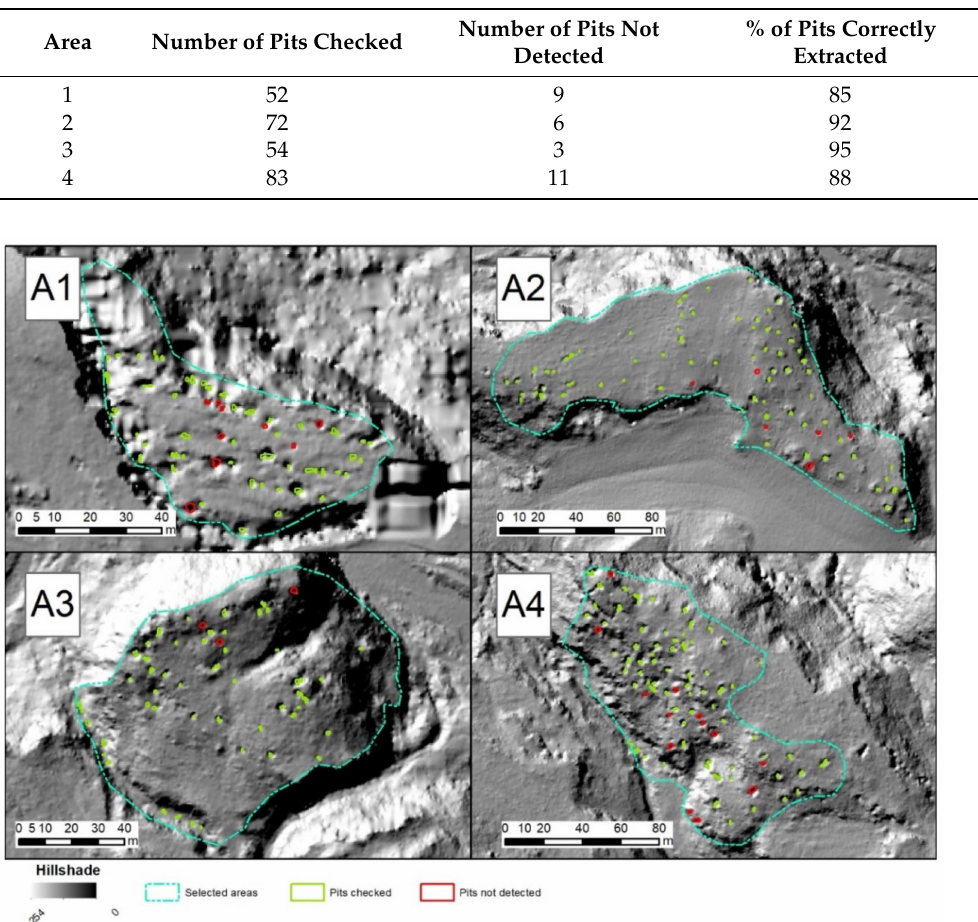
Figure 9. Validation conducted exploiting the enhancement of VTS (on the left), the topographic profile from the DEM (on the right) and ground check. The VT herein showed is HS. Example of profiles derivates for a pit extracted (red), along its main axes (yellow). Table 2. Validation of pits: areas occupied by pits extracted correctly (checked), false positives and pits not detected.